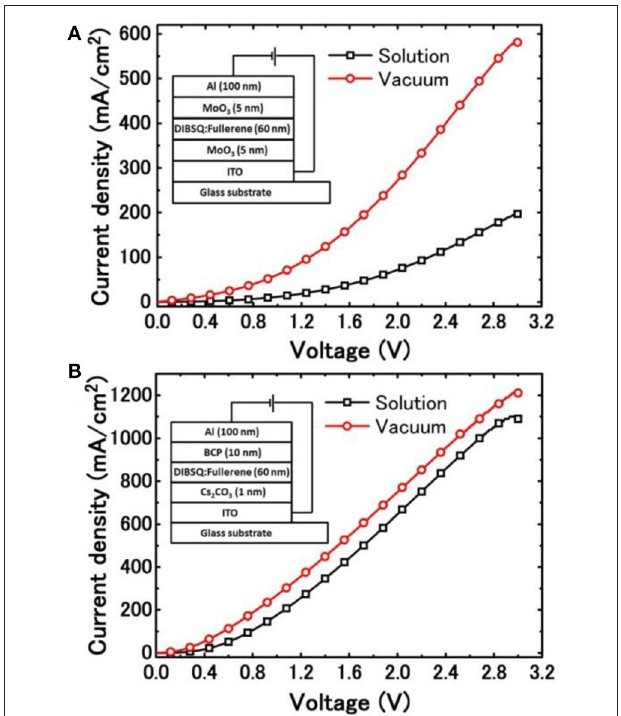
FIGURE 4 | J - V characteristics of (A) hole-only devices and (B) electron-only devices based on solution-processed DIBSQ:PC 71 BM and vacuum-processed DIBSQ:C 70 blend films, inset show the schematic structures of the corresponding single carrier devices.